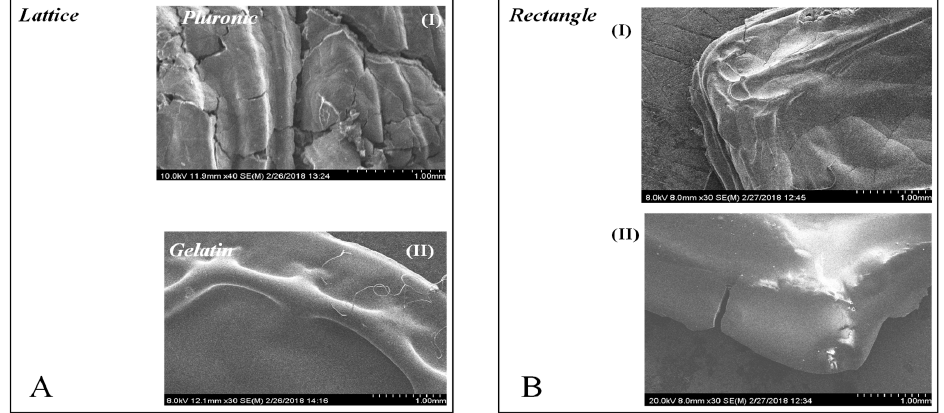
Figure 2. Representative SEM surface images of lattice and rectangular-sheet structures deposited using pluronic and gelatin. ( AI , II ) show the en-face images for the lattice structures printed with Pluronic-F127 and the f-gelatin-based bioink, respectively. ( BI , II ) depict the en-face images for the rectangular structures printed using the same materials, respectively.